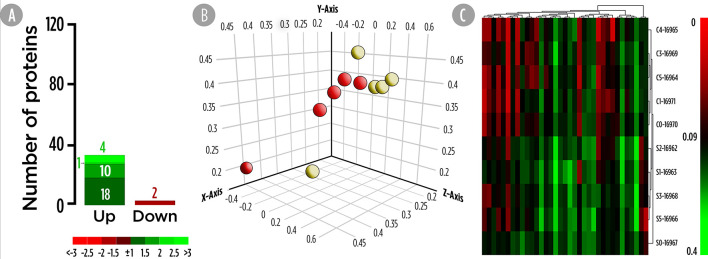
Skin mucus 2-Dimensional electrophoresis separation-based proteomic analysis for gilthead sea bream fed with SDPP supplemented diet. (A) Number of total differential expressed spots (DESs). The green (upregulation) and red (downregulation) color scheme indicates the protein modulation according to its fold-change magnitude interval. (B) Principal component analysis (PCA). Control (red spheres) and SDPP groups (yellow spheres) are represented. (C) Hierarchical clustering heatmap representing the 35 DESs. The results obtained for each 2-D electrophoresis separation for control (C0, C2, C3, and C4) and SDPP group (S0, S1, S2, S3, and S4) are shown.